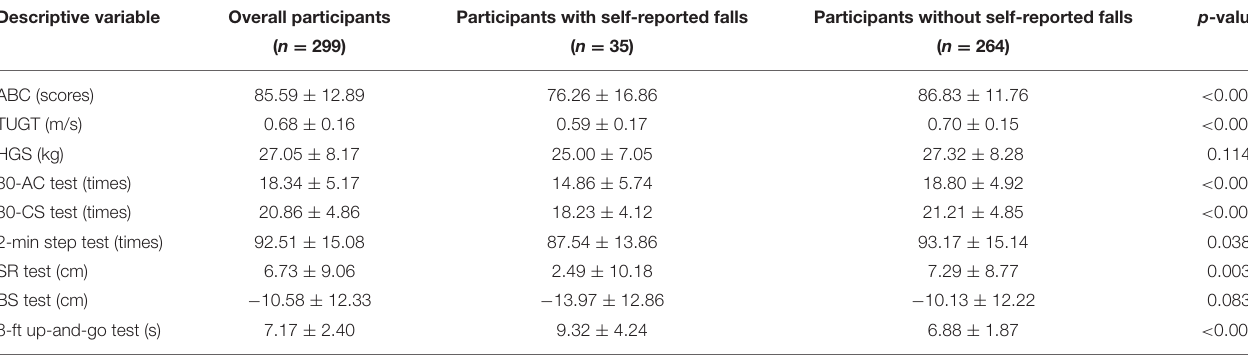
TABLE 2 | HRPF indicators in participants with and without self-reported falls. Descriptive variable